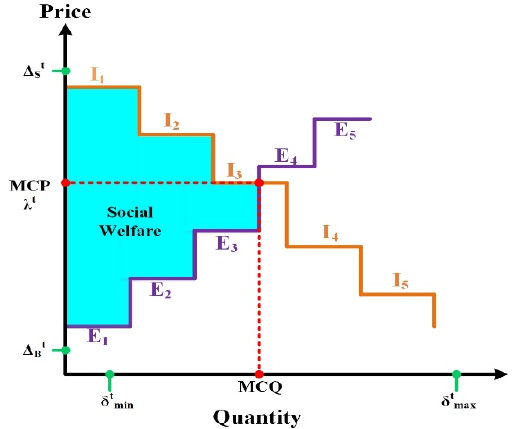
Figure 2. TEMO market-clearing mechanism using DAS.